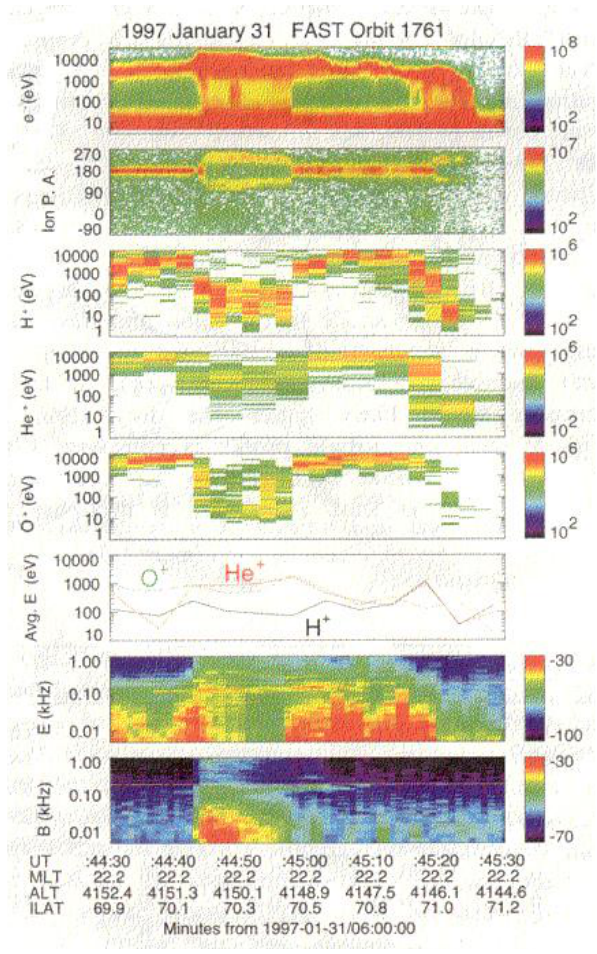
Fig. 1. Overview of the EMIC ion conics event from the nightside on orbit 1971 (Lund et al.,